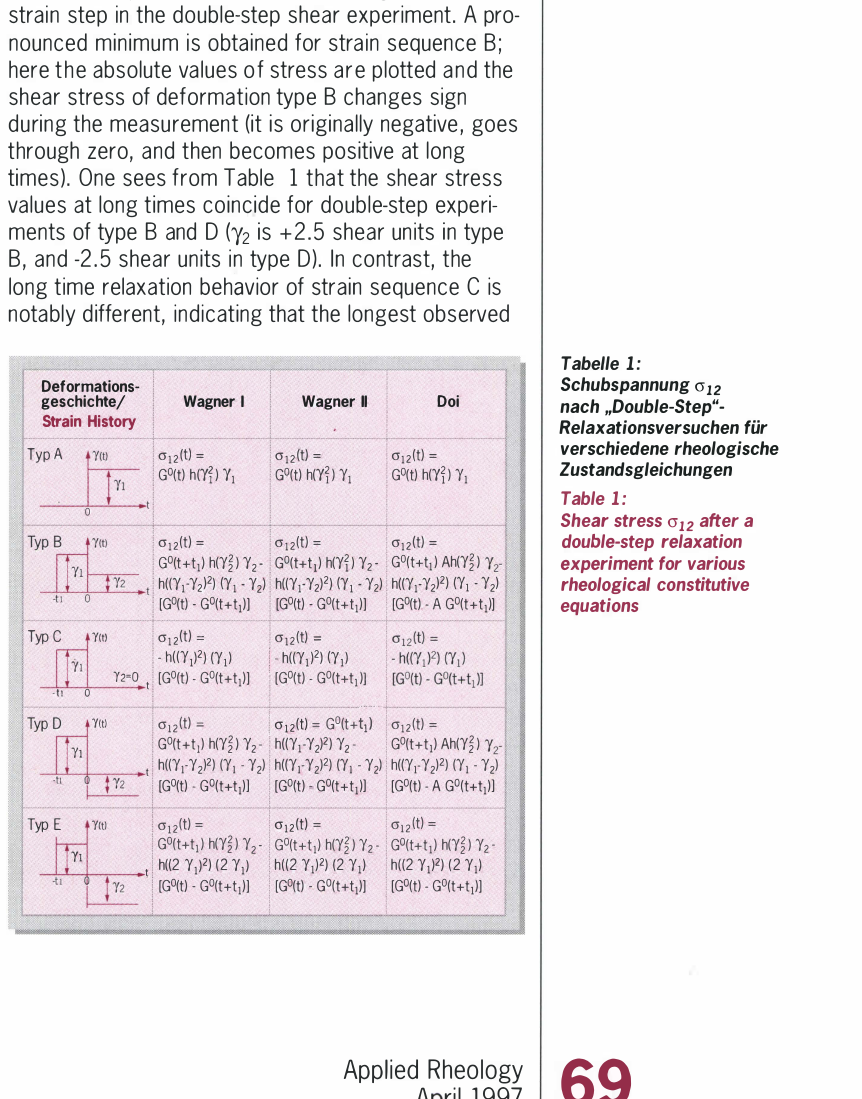
Table 1: Shear stress cr 12 after a double-step relaxation experiment for